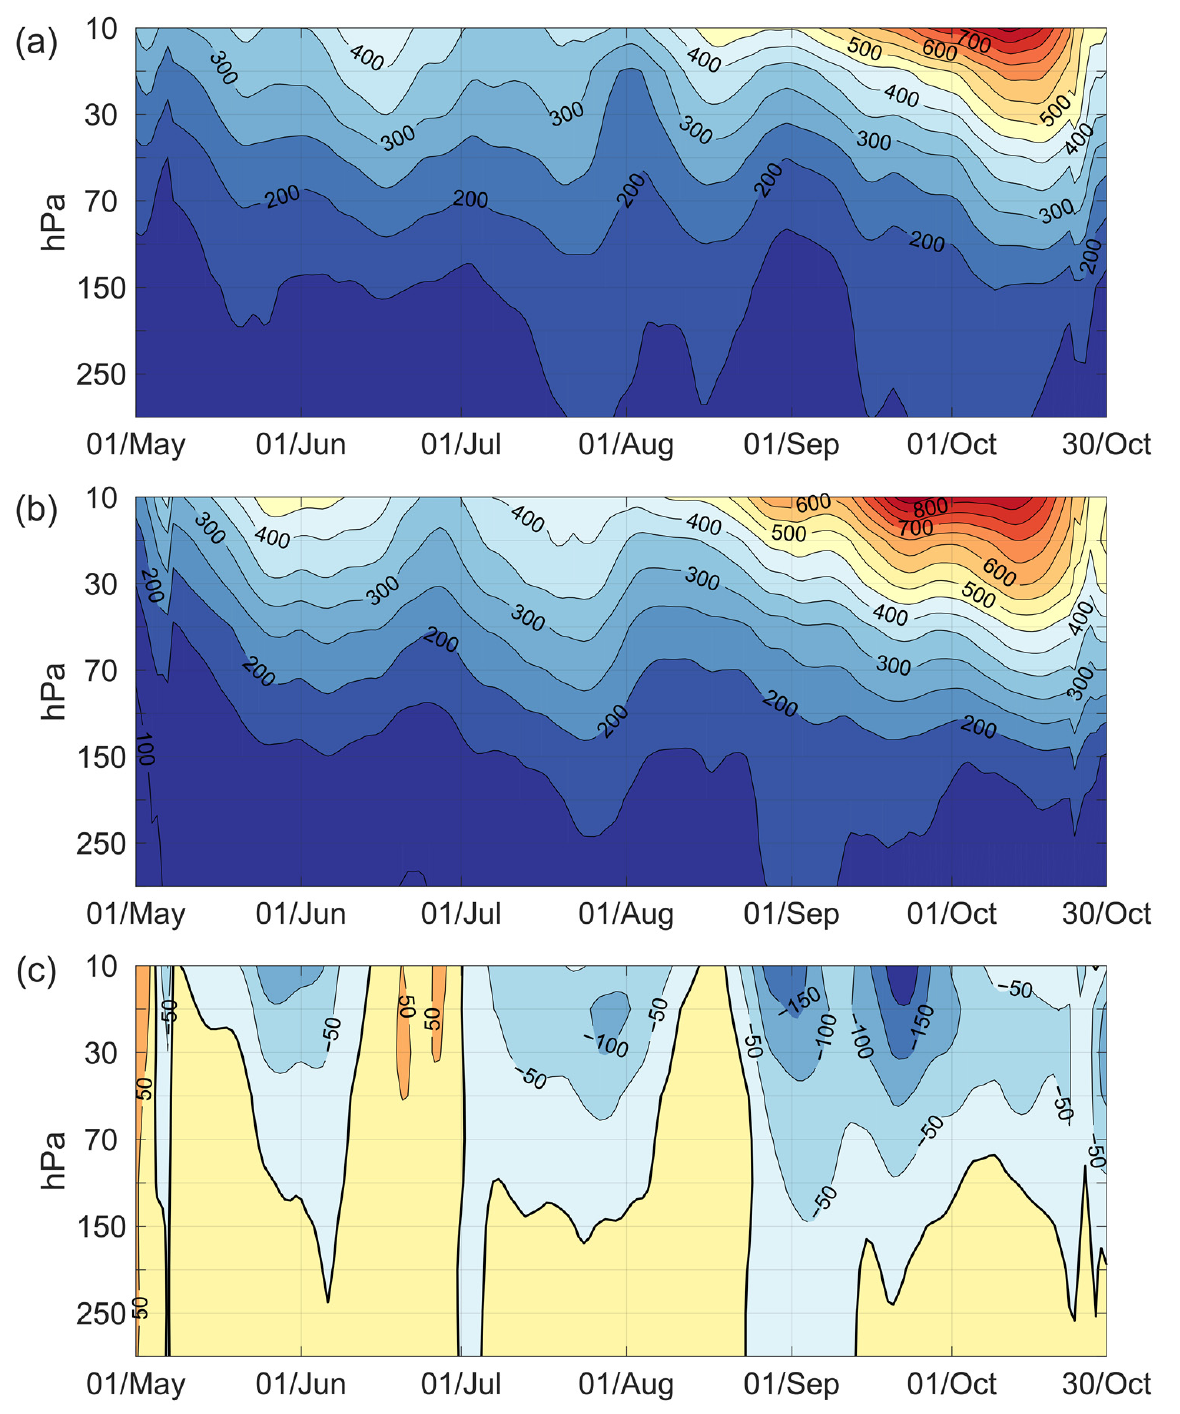
Figure 11. Composite vertical sections of amplitude of wave with zonal wave number 1 averaged between 50 and 70° S for ( a ) Eastern Pacific and ( b ) Central Pacific El Niño events and ( c ) difference between composites of EP and CP El Niño events. Values are smoothed with a 15-day running mean. Contour interval is 50 gpm. Black bold line indicates zero isoline.